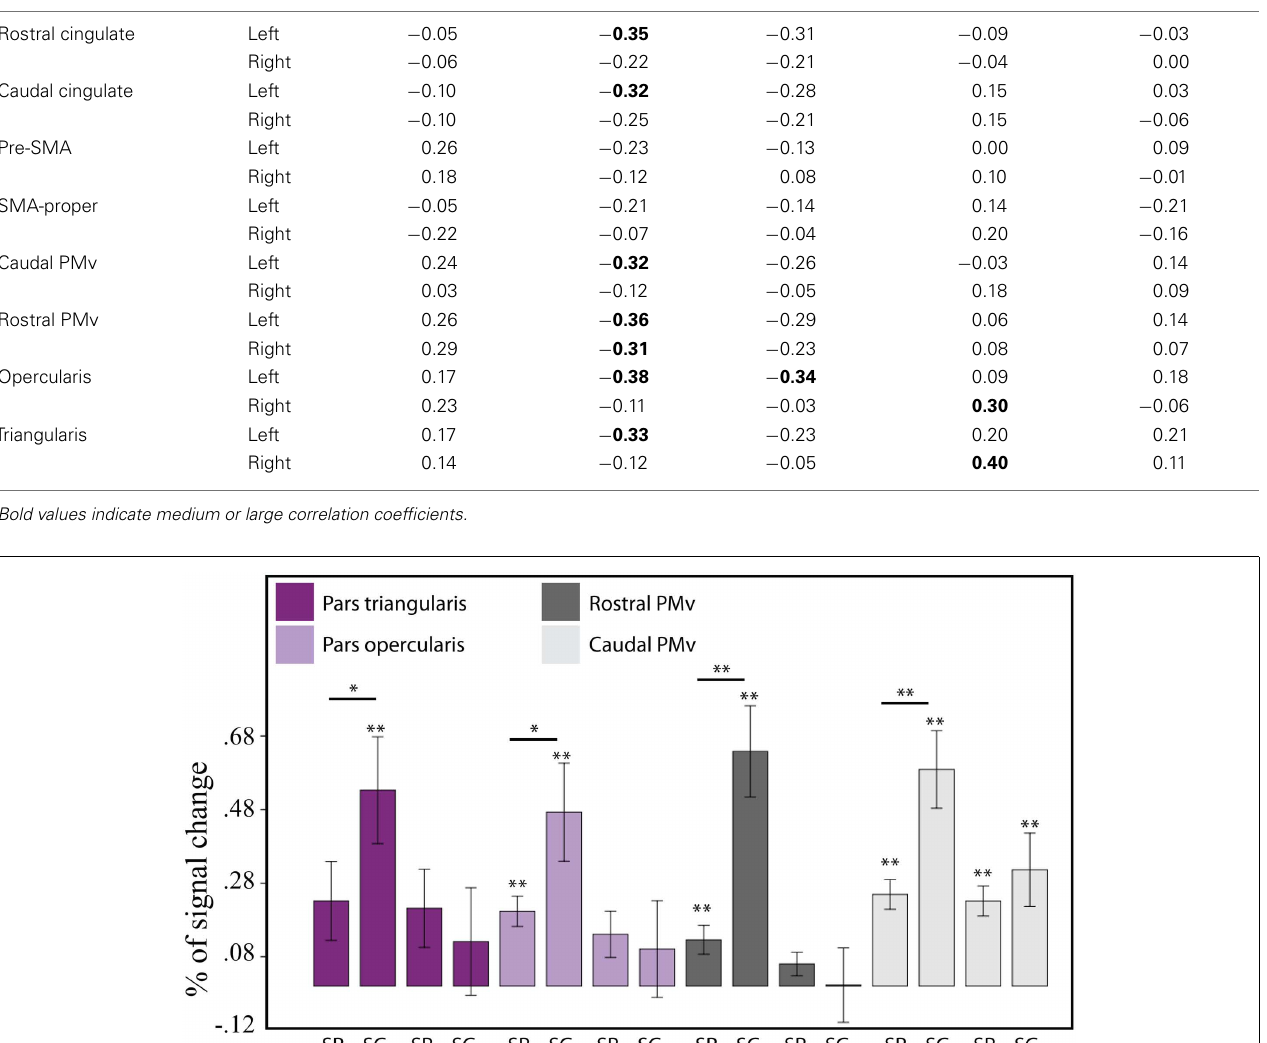
FIGURE 5 | Brain activity (expressed as a percentage of signal change) for sentence repetition (SR) and sentence generation (SG), for the lateral frontal ROI group. LH = left hemisphere, RH = right hemisphere. From left to right: IFG pars triangularis (left, right), IFG pars opercularis,